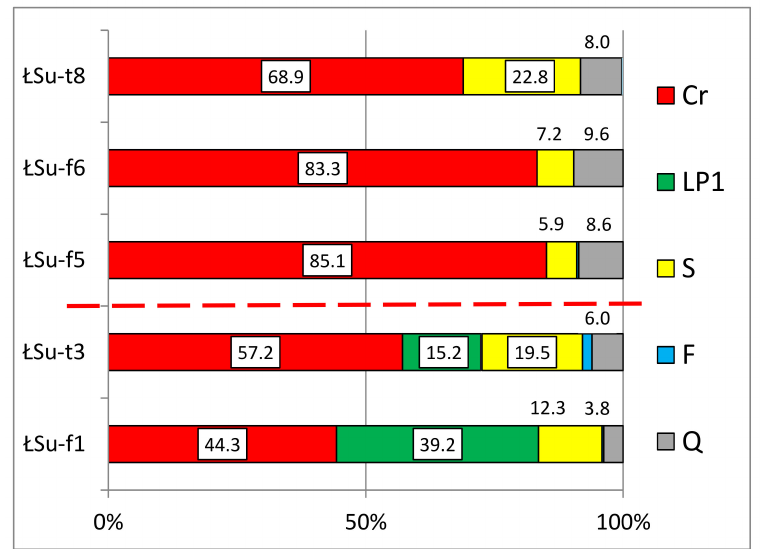
Figure 5. Petrographic composition of 4–10 mm gravels in Łubienica-Superunki. Explanation: for symbols of samples see Table 1; Cr—crystallines, LP1—Lower Palaeozoic limestones (grey), S—sandstones, F—flints, Q—quartz. The red dashed line divides the profile into the lower and upper part.